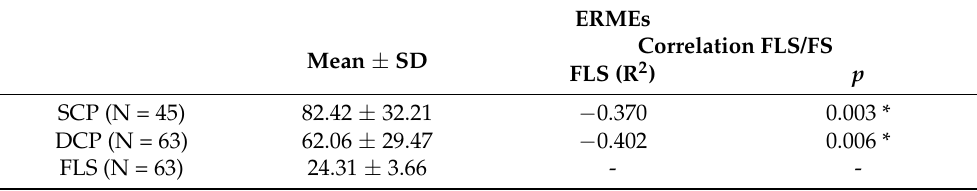
Table 3. Group of focal areas with flow signal (FS) < (mean ± 2SD) or FS > (mean ± 2SD). Descriptive statistics and correlations between FS and FLS, significant in both capillary plexuses in this group of affected